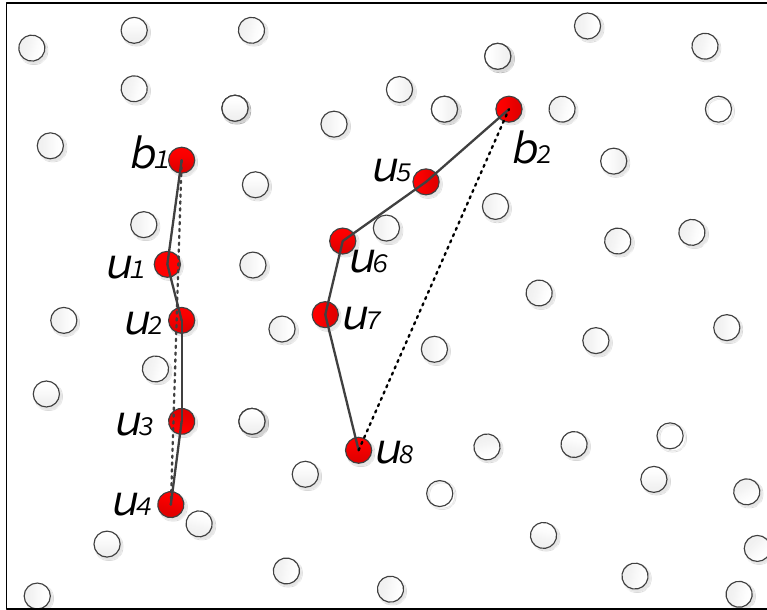
Figure 4. Comparison diagram of the shortest communication distance and actual distance.